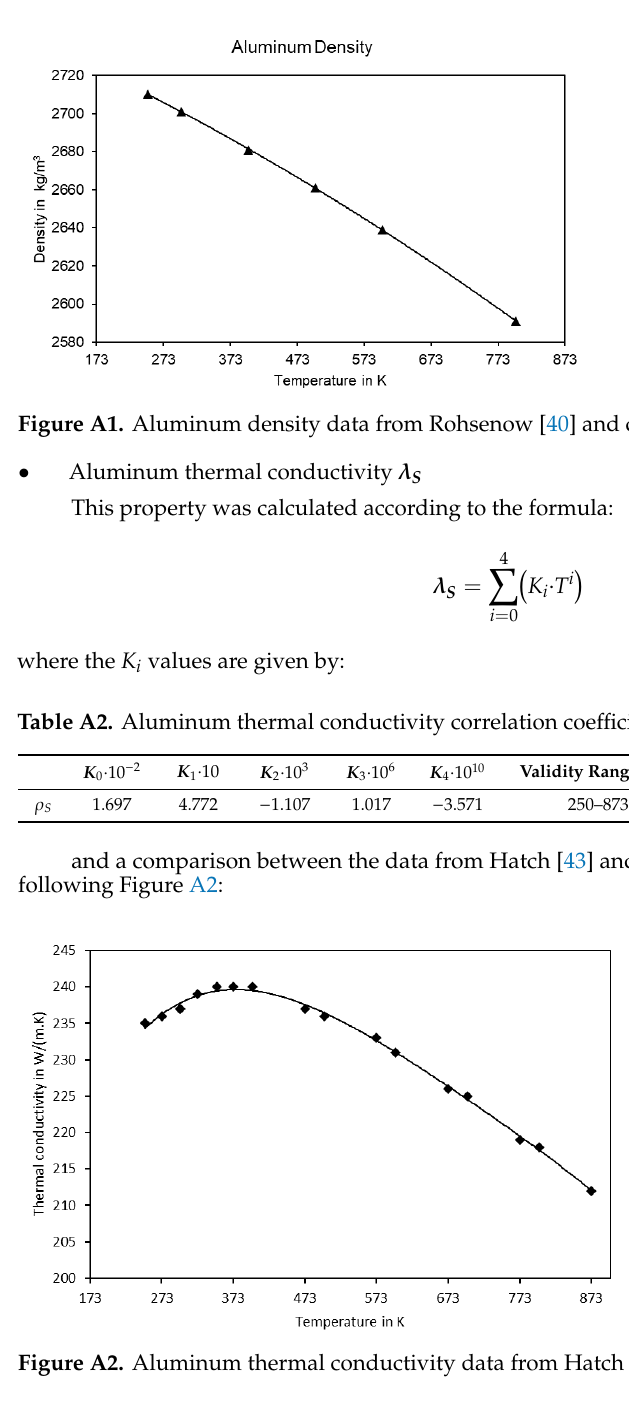
Figure A2. Aluminum thermal conductivity data from Hatch [43] and correlation.